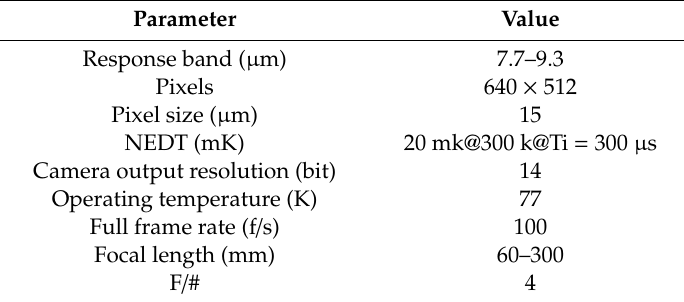
Table 1. Parameters of the experimental IR system.